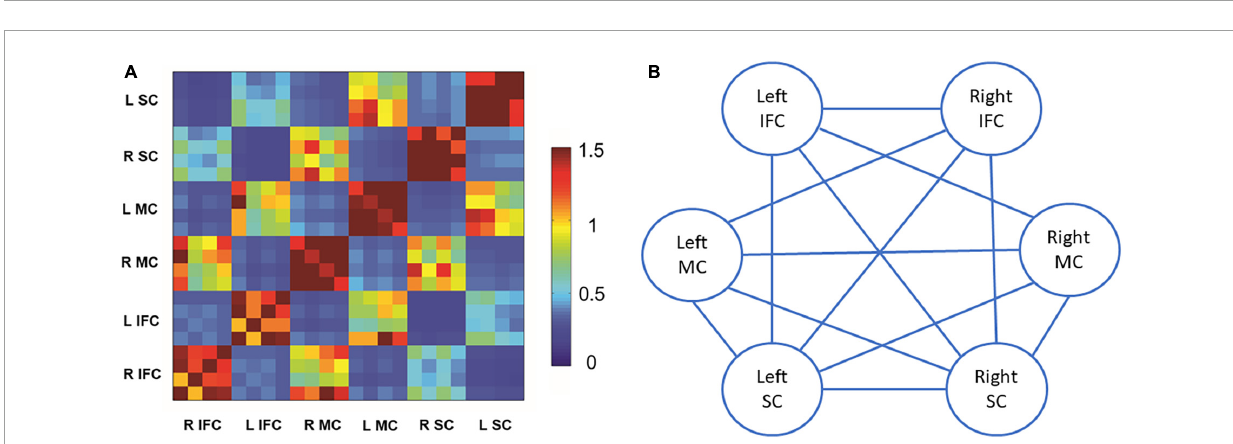
FIGURE2 Beta band coherence in each pair of brain regions of interest and the correlations with stop-signal reaction time (SSRT). (A) Beta band coherence between bilateral motor cortex, somatosensory cortex, and inferior frontal cortex. Data are presented as z-scores of coherences. There were four electroencephalography (EEG) channels included for each brain region of interest. (B) Illustration of correlations between SSRT and beta band coherence in each pair of brain regions of interest. Solid lines stand for significant positive correlations between SSRT and beta band coherence in the pair of brain regions. L stands for left, and R stands for right. SC refers to somatosensory cortex. MC refers to motor cortex. IFC refers to inferior frontal